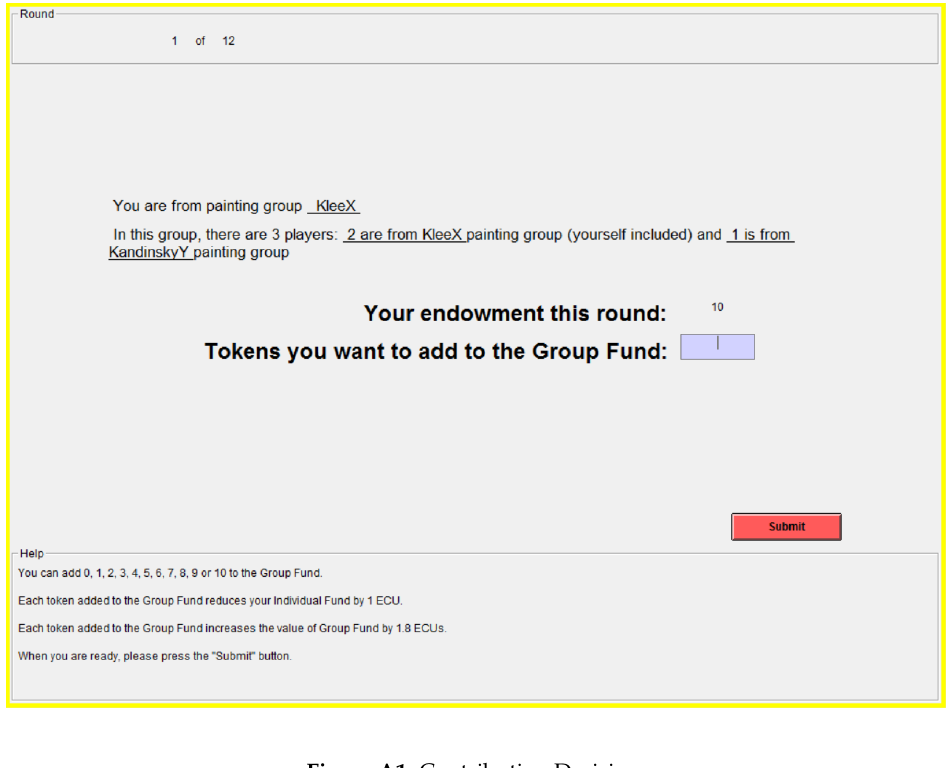
Figure A1. Contribution Decision.